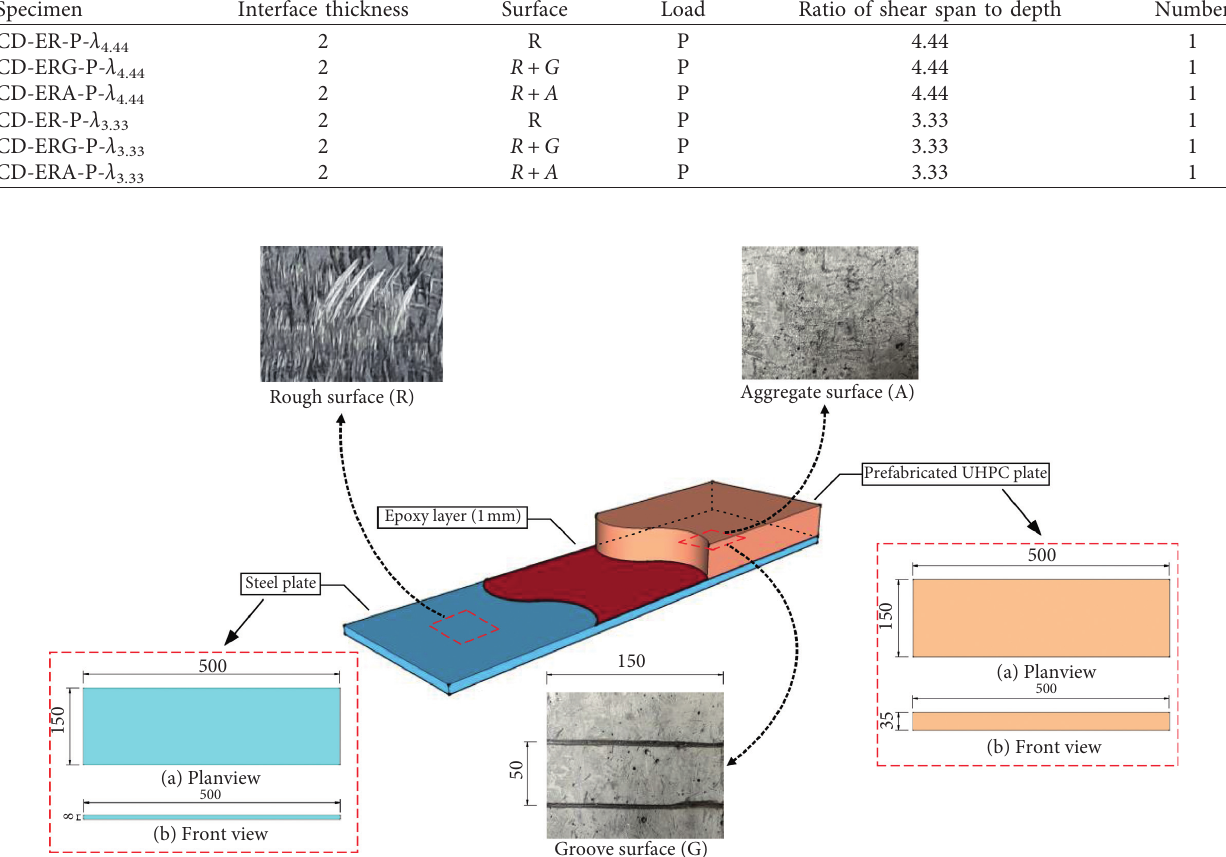
Figure 1: Detailed information on the specimen (Unit: mm).